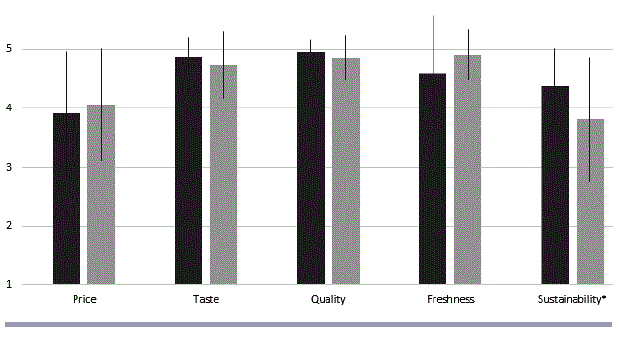
Fig. 2 . Ocean Wise versus non-Ocean Wise values of the importance of each category when purchasing seafood.